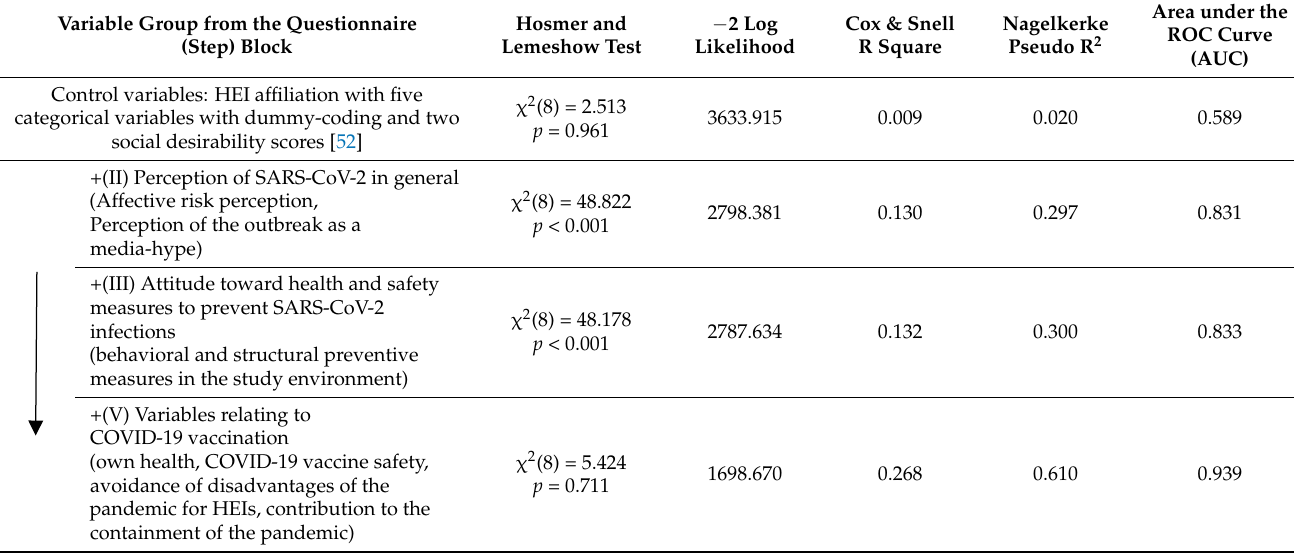
Table 2. Model summary for each block of the multivariate binary logistic regression analysis.